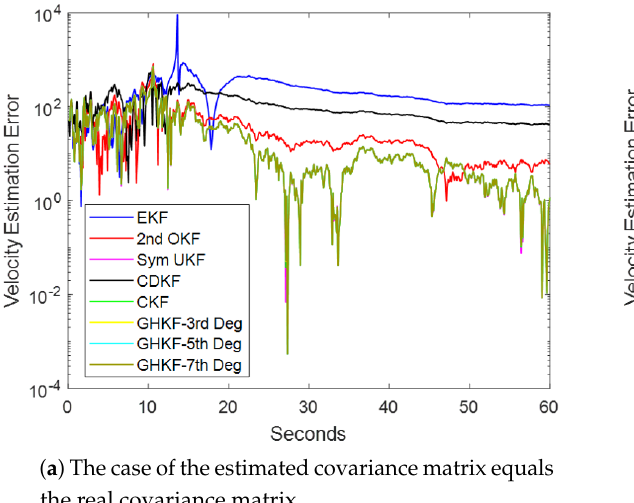
Figure 26. Performance validation of EKF, 2nd Order KF, UKF, CDKF, CKF with GHKFs algorithm. This study focused on a complexity reduction technique for the Bayesian filtering based on the partitioning of the state-space. It proved that the partitioning schemes can efficiently be used to overcome the curse of dimensionality in the GHKF. The simulation result shows that a nearly-optimal performance can be attained using GHKF with non-linear filtering problems. Authors’ own